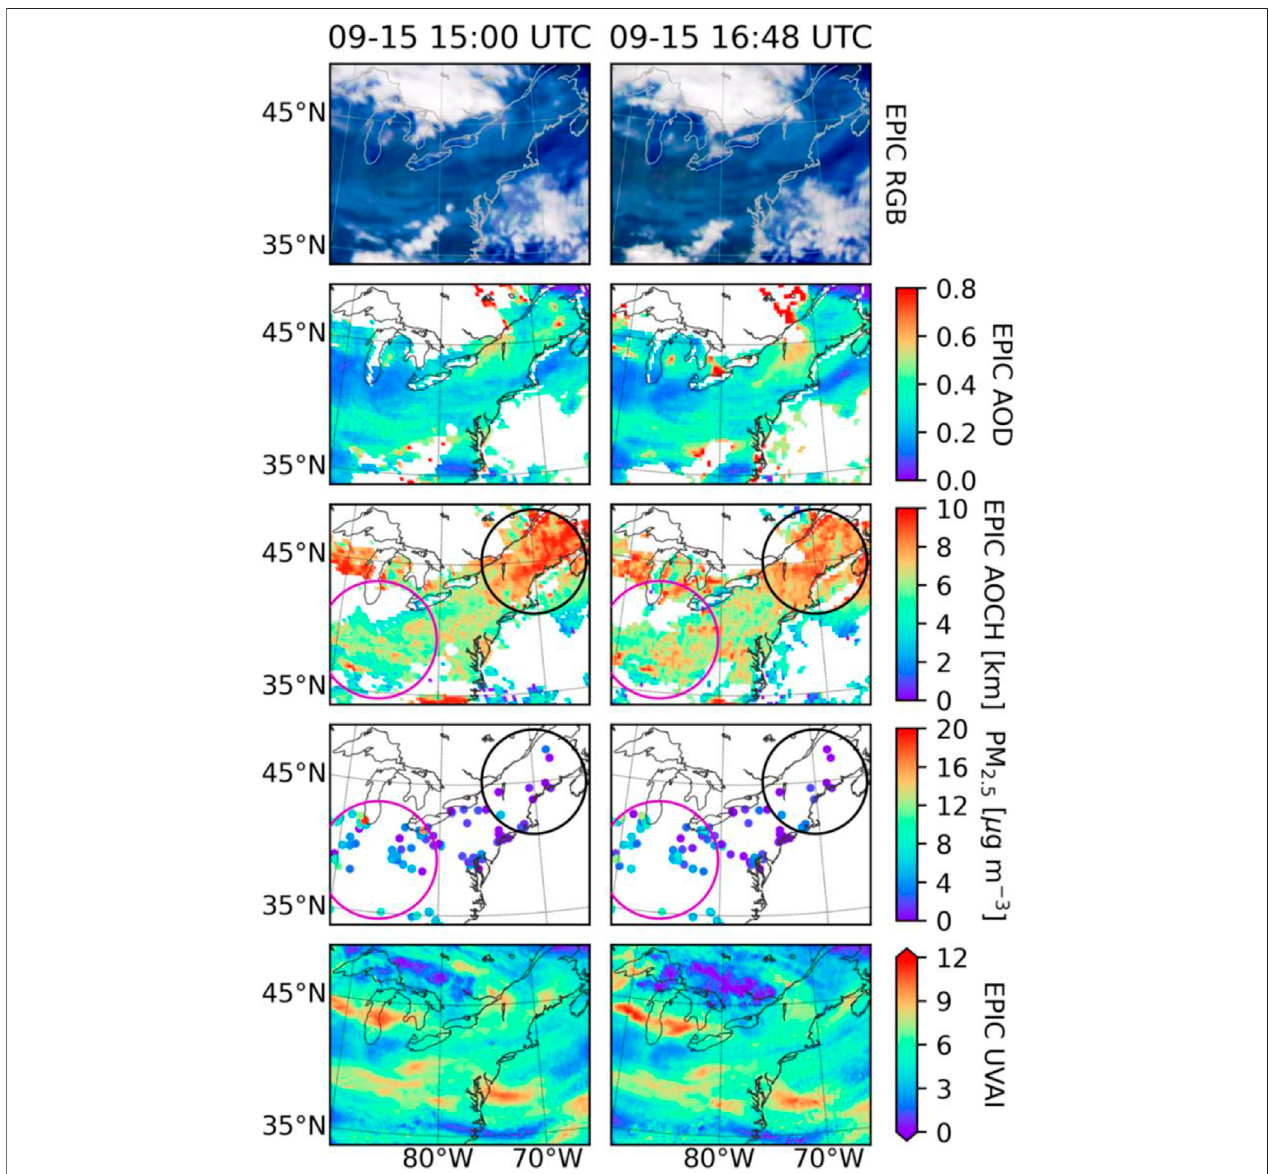
FIGURE 7 | Same as Figure 6 , but for 15:00 – 16:48 UTC on September 15, 2020.